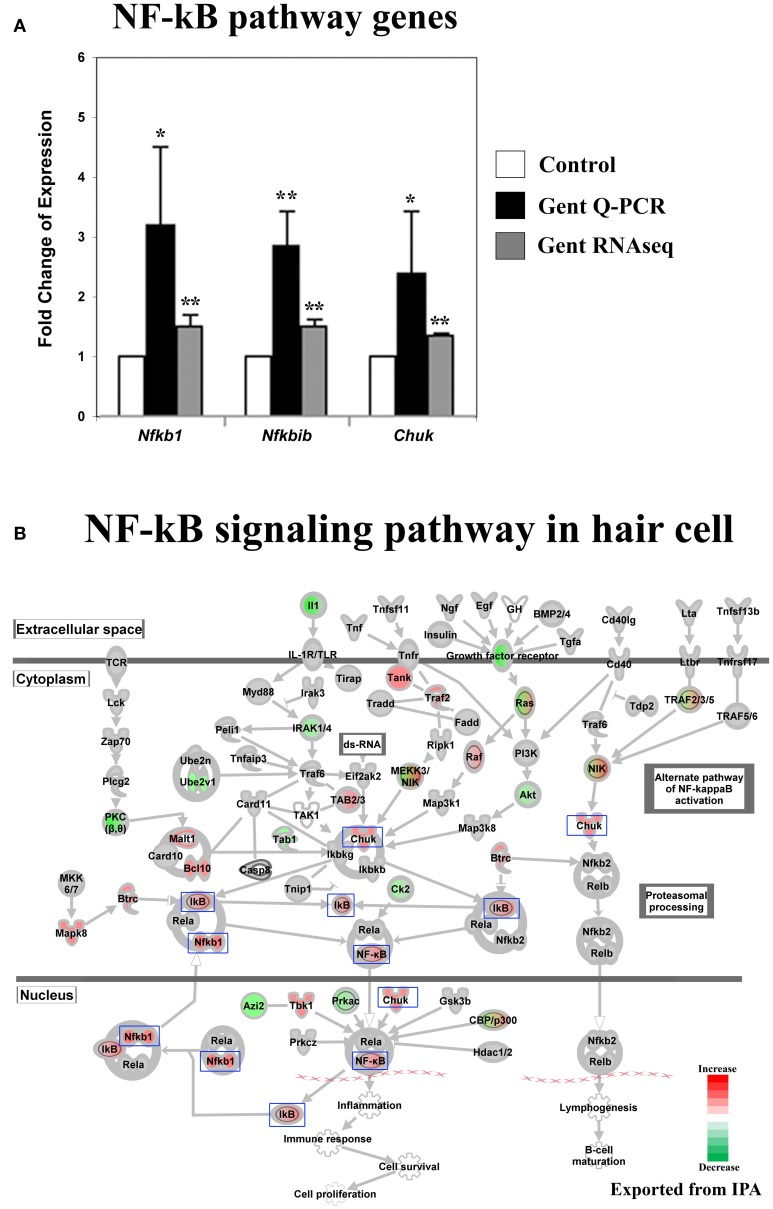
Gentamicin-induced changes in expression of genes in the NF-κB pathway. (A) Q-PCR results validating increased messenger RNA levels in hair cells after gentamicin treatment. Error bar, standard deviation: *p < 0.05; **p < 0.01. (B) NF-κB pathway with color-coded expression changes suggesting early transcriptional response to gentamicin. Only genes with significant expression changes are colored. Red, increased expression; green, decreased expression relative to control; half red-half green, symbols for nodes consisting of multiple genes with some genes upregulated and some genes downregulated. Genes validated and discussed in the text are boxed in the corresponding protein pathway diagrams.